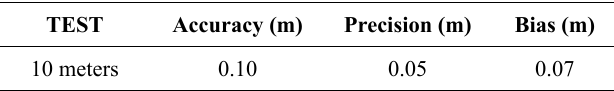
Table 3- values obtained in the calculations of accuracy, precision, and bias of the first experiment.